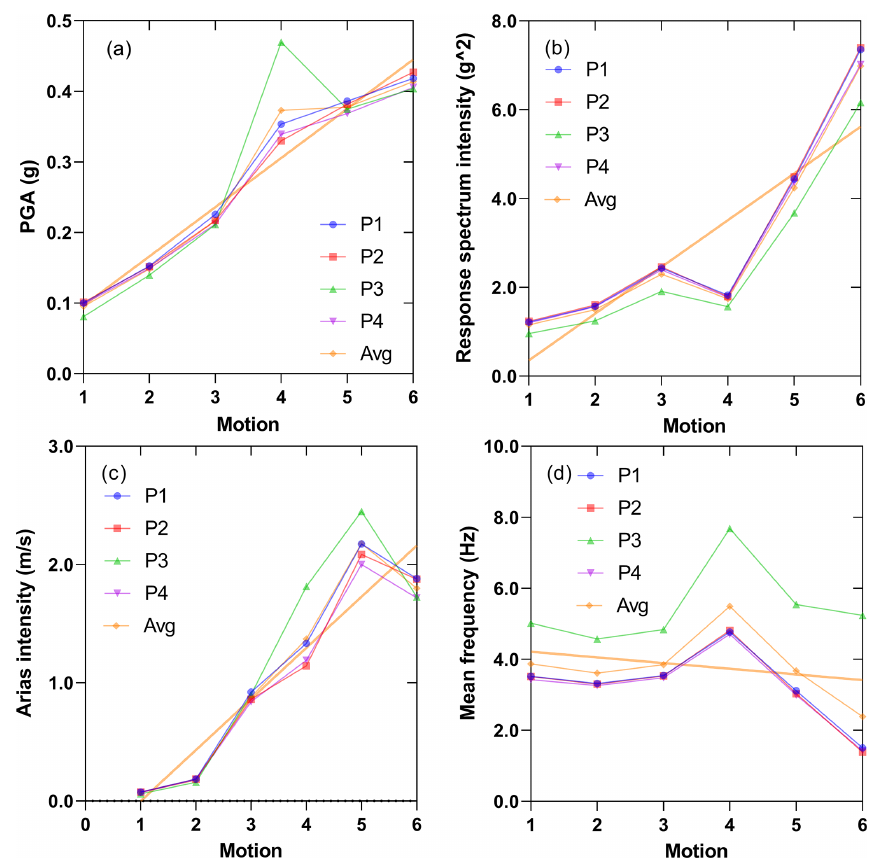
Figure 17. Sensitivity of input ground motion in Zone II. (a) Peak ground acceleration, (b) response spectrum intensity, (c) Arias intensity, and (d) mean frequency. Soil profiles: P1: CST football ground; P2: CST hostel; P3: Phajoding; and P4: Monastery area. Table 4. Descriptive statistics for averaged ground response parameters in Zone I for all four soil profiles and six input ground motions. PGA Arias Response Predominant Mean (g) intensity spectrum period frequency (ms − 1 ) intensity (s) (Hz) (g 2 ) Mean 0.270 1.073 Standard deviation